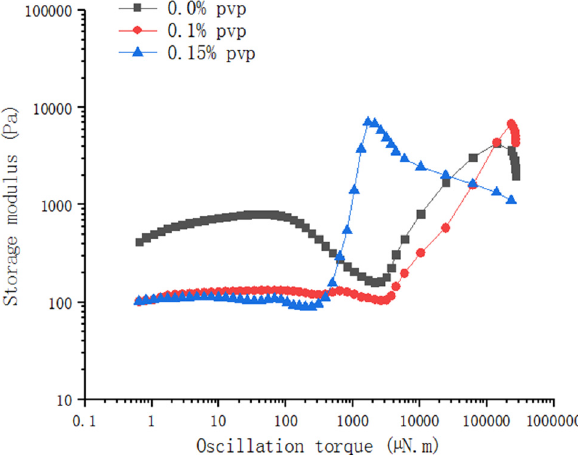
Figure 8: The MWCNTs – PVP/SiO 2 – STF system storage modulus and the strain relationship curve.